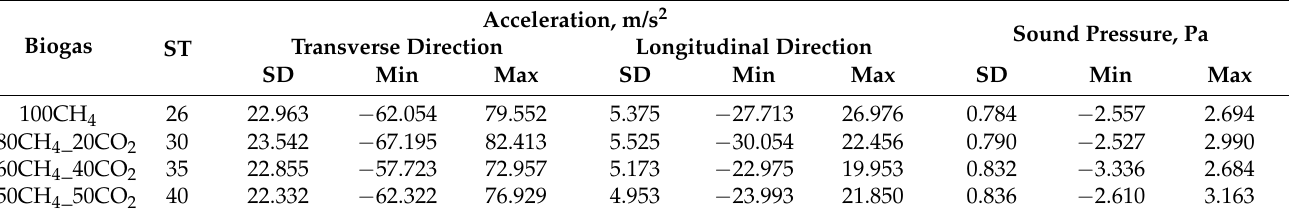
Table 6. Biogas properties and ST cases.